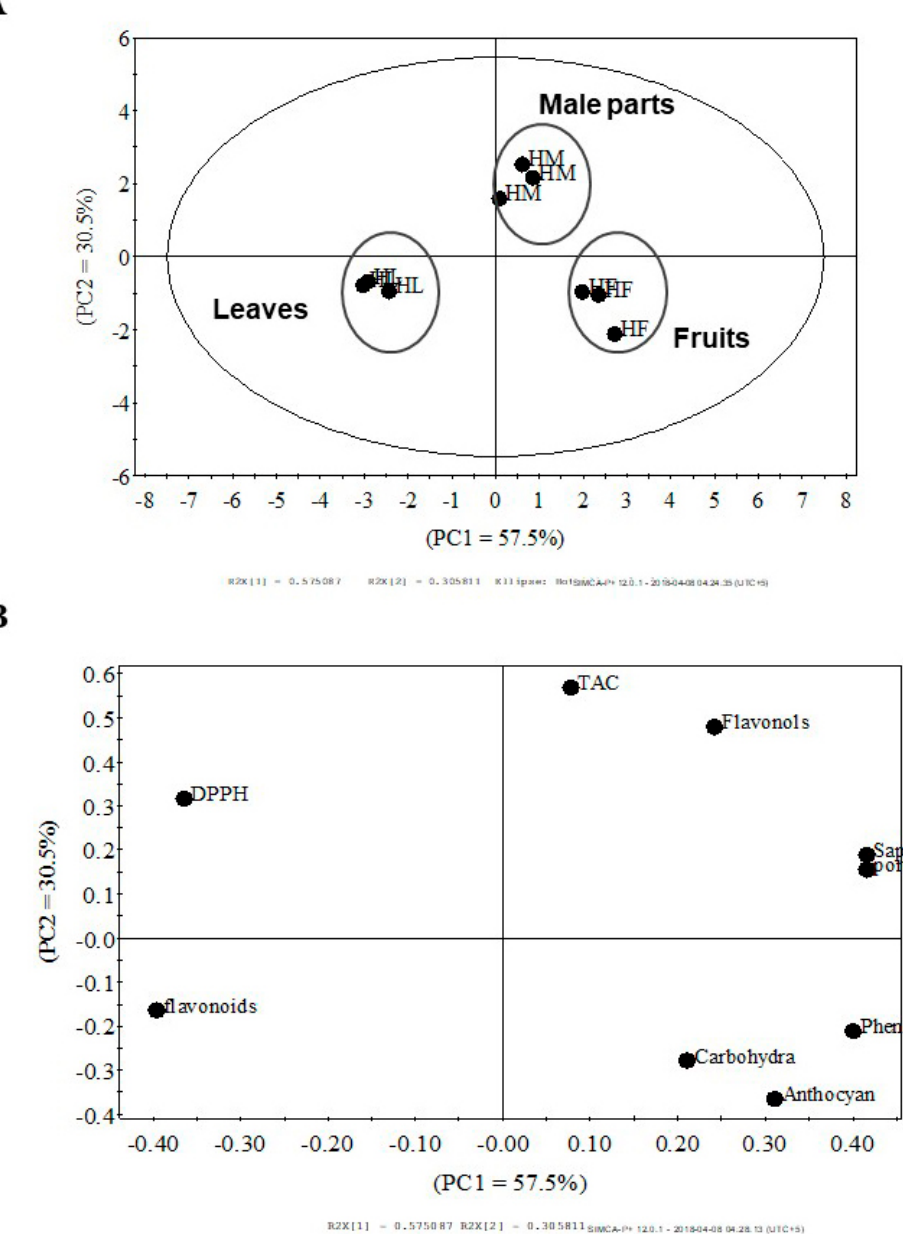
Figure 1. Score scatter plot of PC1 versus PC2 ( A ), and the score loading plot of PC1 versus PC2 of the metabolomic profiling of di ff erent parts of H. thebaica ( B ). HL = doum palm leaves, HM = doum palm male parts and HF = doum palm fruits.